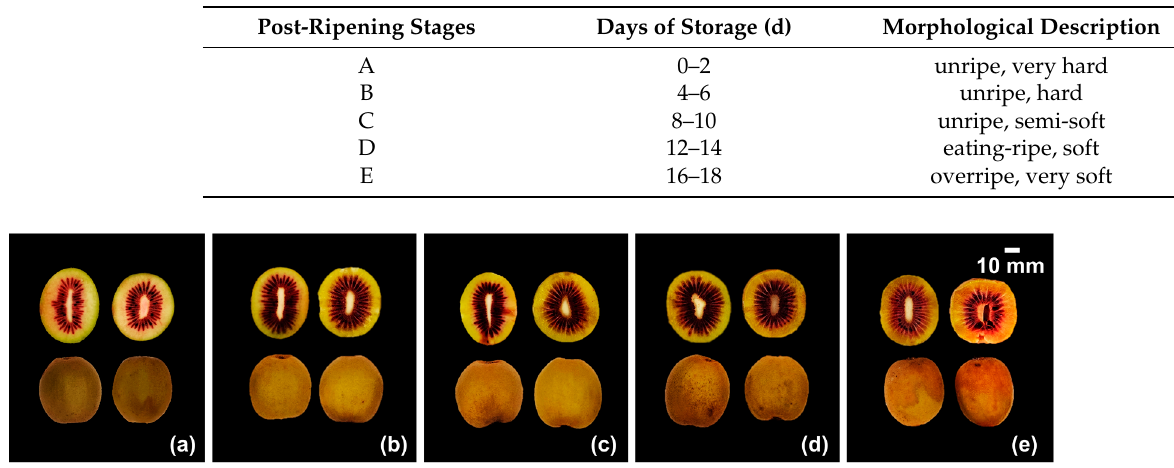
Figure 1. Morphological characteristics of kiwifruit “Hongshi No. 2” at di ff erent stages. Pictures ( a – e ) are the horizontal section and complete appearance of kiwifruits at di ff erent stages a, b, c, d, and e, respectively.